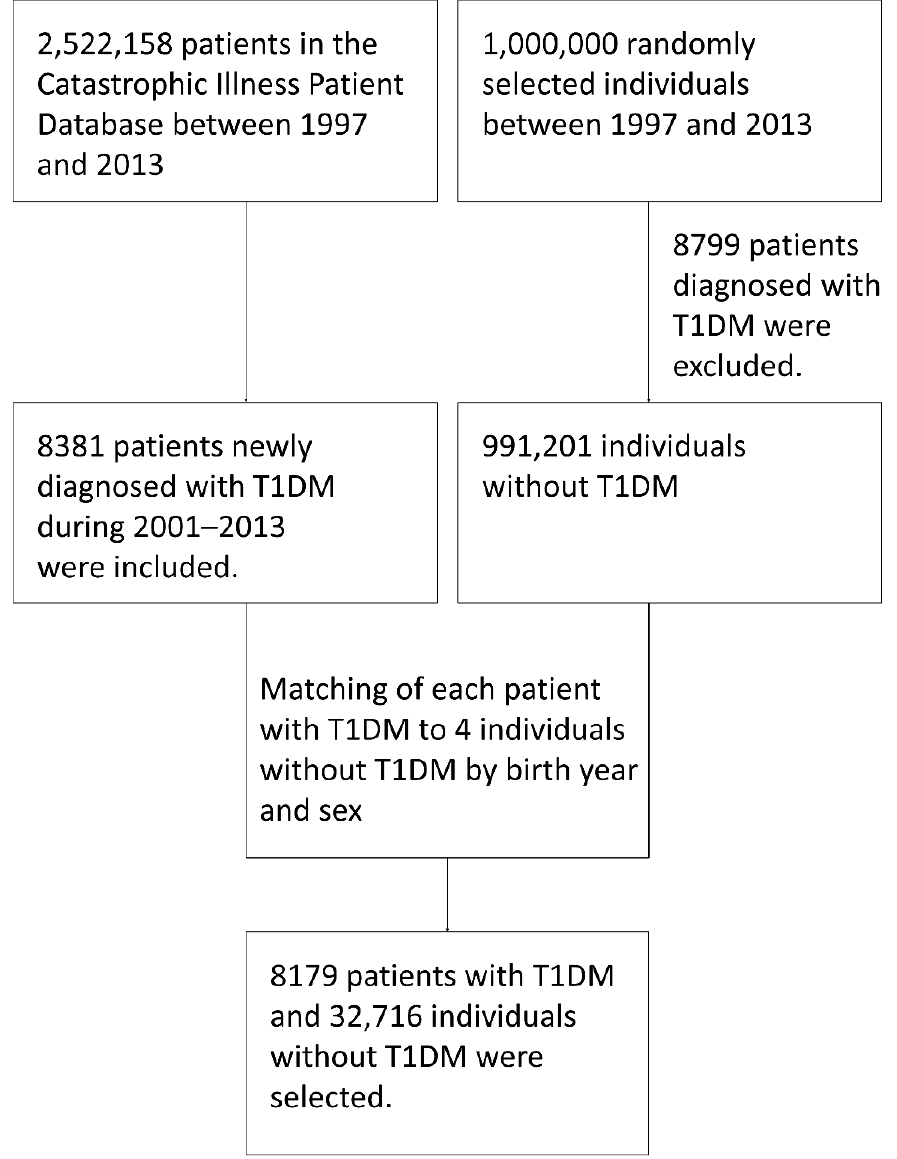
Figure 1. Flowchart of subject inclusion and exclusion. T1DM, type 1 diabetes mellitus. Table 1. Distribution of selected characteristics of 8179 cases and 32,716 controls.